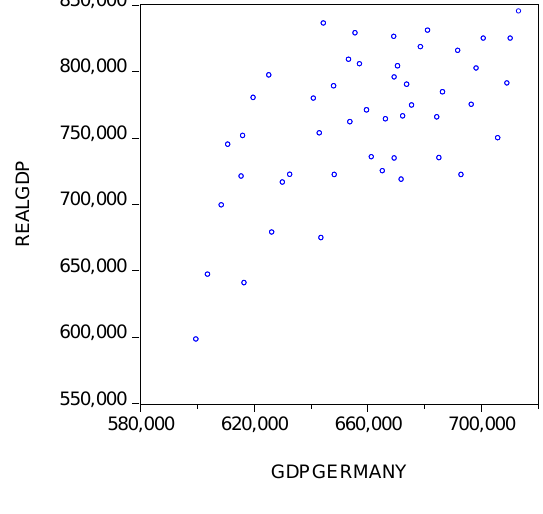
Figure 3. Scatter Diagram between Serbia’s Real GDP (REALGDP) and Germany’s Real